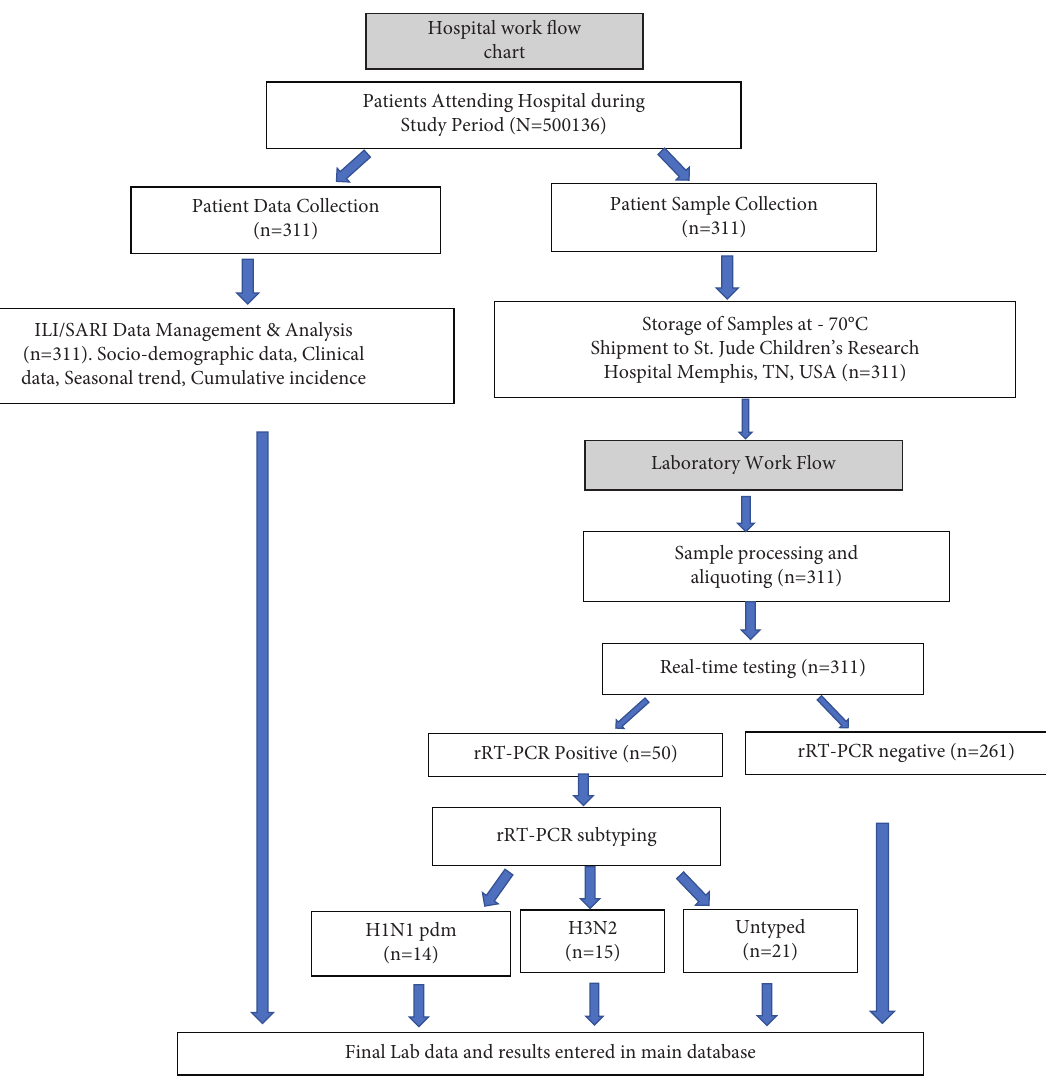
Figure 1: Flow chart of hospital surveillance